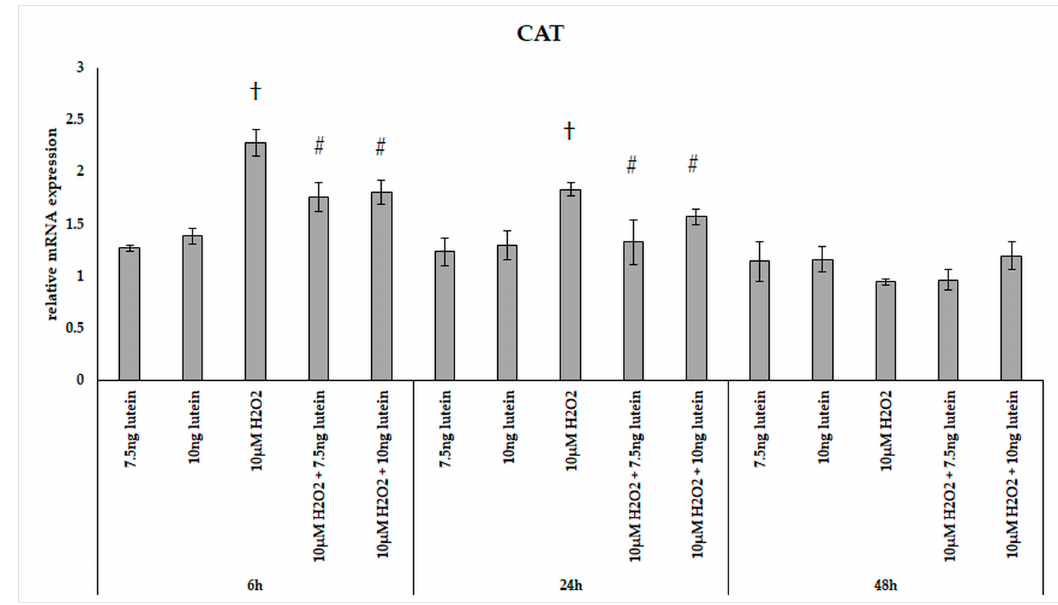
Figure 2. Relative mRNA expression of catalase in lutein and in H 2 O 2 -treated BV-2 cells. The columns represent the mean values and error bars indicate the standard deviation (SD) of three independent experiments ( n = 3), each performed in triplicate, and are presented relative to own control cells. † represents statistical significance of H 2 O 2 -treated cells compared to controls, # marks statistical significance of combined (lutein with H 2 O 2 ) treatments compared to H 2 O 2 treatments; the level of significance was p < 0.05. Real-time PCR was performed with the SYBR green protocol using gene-specific primers. β -actin was used as house-keeping gene for the normalization. The relative expression of controls was regarded as 1.